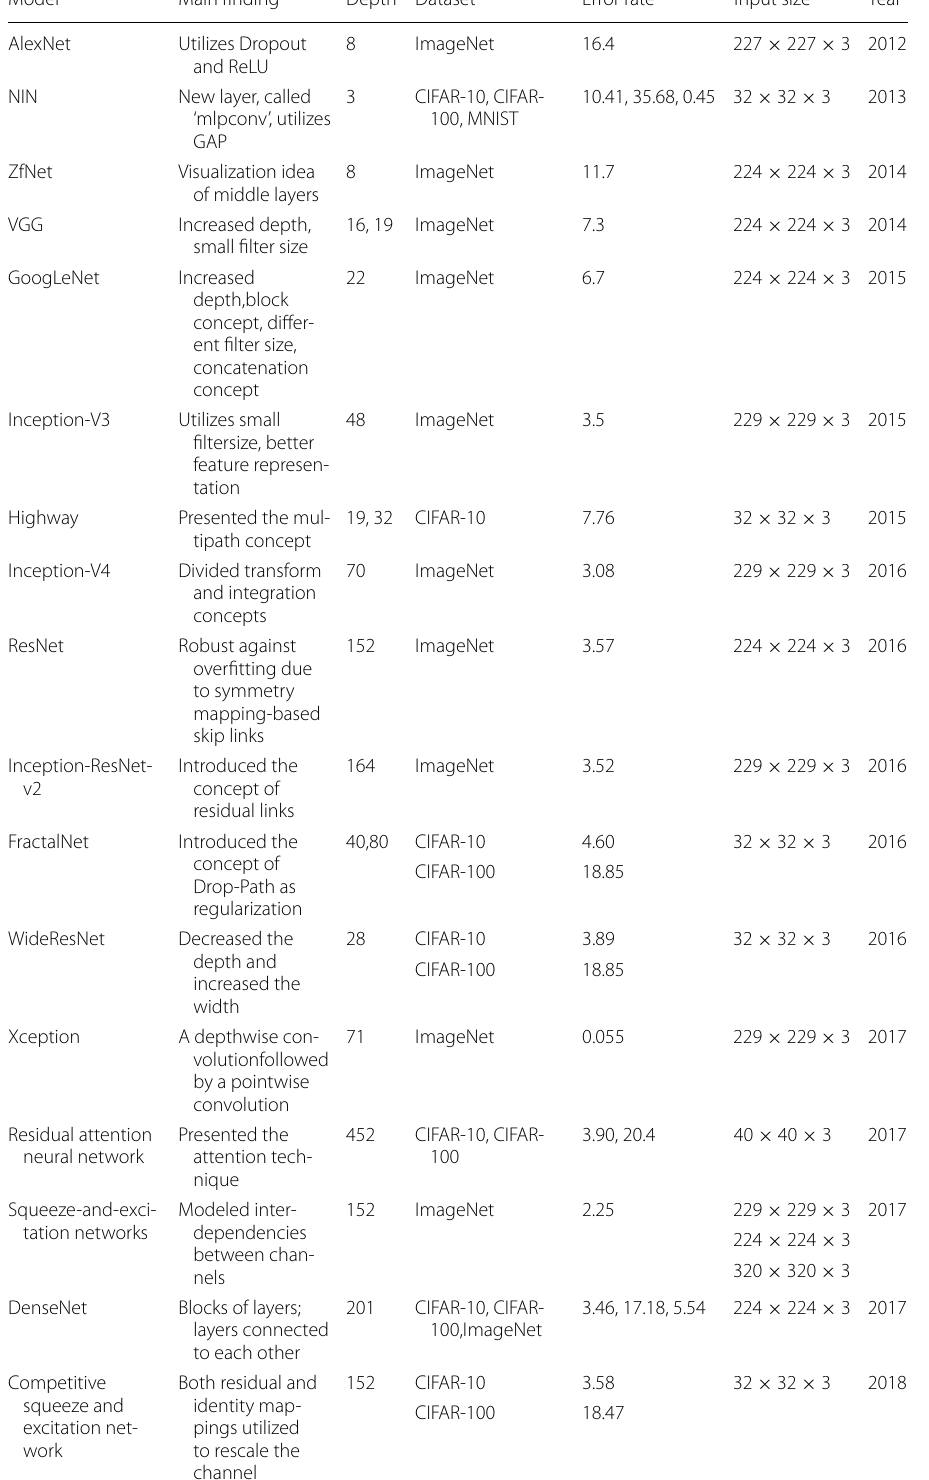
Table 2 Brief overview of CNN architectures